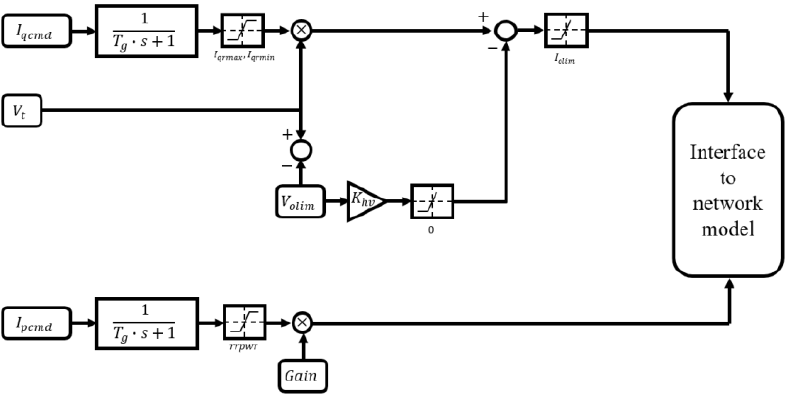
Figure 9. The simplified universal model of the WECC energy storage systems—REEC